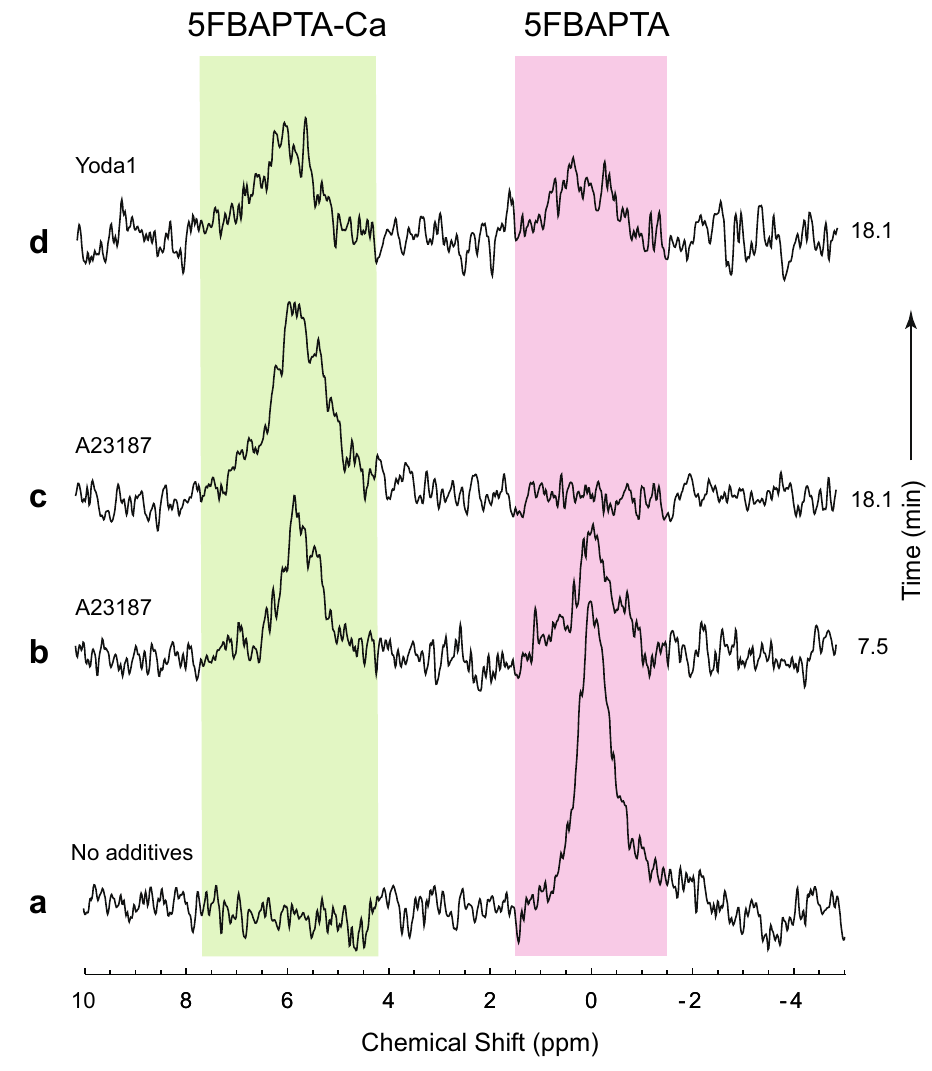
Figure 4. 19 F NMR spectra showing A23187 (and Yoda1 in comparison) stimulated uptake of Ca 2+ in RBCs loaded with 5FBAPTA (4 mmol [L RBC] −1 ), at 37 °C. Pink highlights the resonance corresponding to intracellular free 5FBAPTA that was assigned the chemical shift δ = 0.0 ppm; and the green highlights the peak from the calcium complex that was centred at ~ 5.8 ppm. The sample of 0.5 mL RBCs ( Ht = 0.62) was constituted in 154 mM NaCl, 10 mM glucose. ( a ) The RBCs had been loaded with 4 mM 5FBAPTA as described in Methods. Then, for ( b , c ), added with brisk mixing (by five-fold rapid inversion and re-inversion of the NMR tube) were: 5 µL 1 M CaCl 2 making the concentration 10 mM averaged over the volume of the sample; and 0.5 µL 20 mM A23187 in DMSO giving a concentration of 32 µmol (L RBC) −1 . For ( d ) 5 µL 1 M CaCl 2 and 1.0 µL 14 mM Yoda1 in DMSO giving a concentration of 45 µmol (L RBC) −1 were mixed into the 0.5 mL susupension. The time indicated on the right of each spectrum was the mid-point of spectral accumulation after a 2 min lag between mixing the sample and starting FID accumulation. NMR settings were as for Fig. 1 except the time per spectrum was 10 min 47